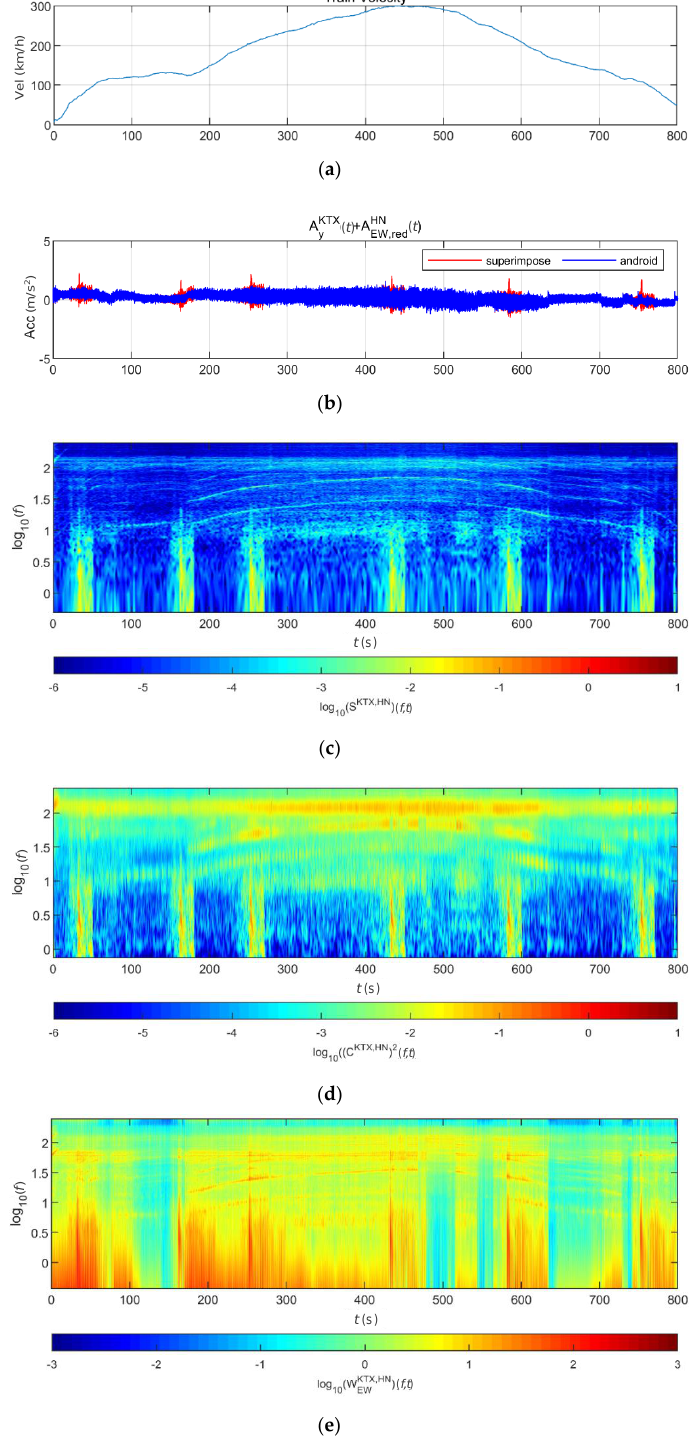
Figure 26. Combination of train data with the Hachinohe earthquake data (scaled to 1000-year return period): ( a ) velocity; ( b ) lateral acceleration time series; ( c ) STFT; ( d ) WT; ( e ) WVD.